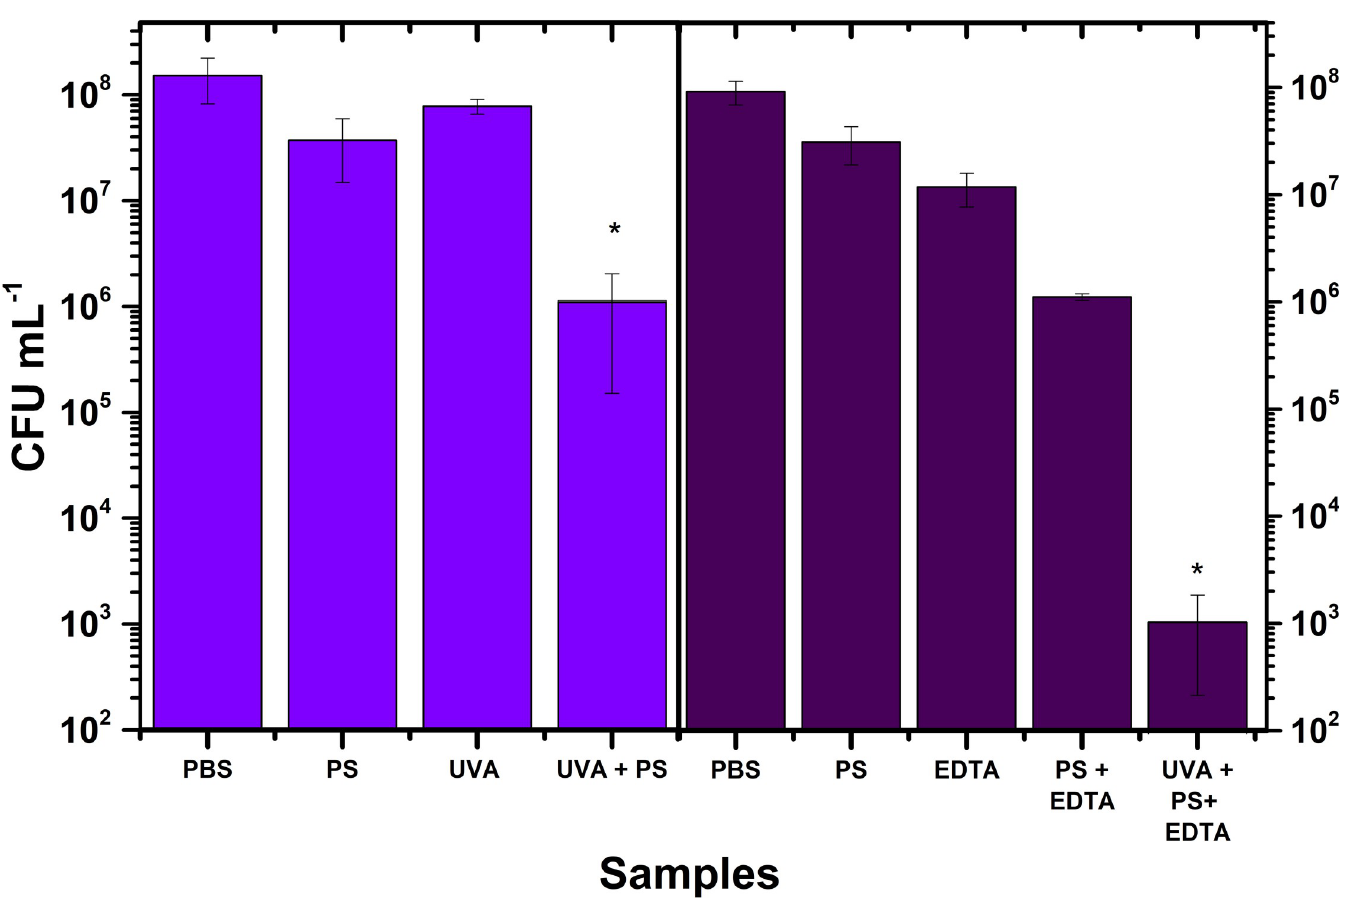
Fig 6. E . coli photoinactivation with pheomelanin nanoparticles excited with UVA radiation with and without EDTA (10 mM). The cultures at 166 μ g/mL of pheomelanin nanoparticles were irradiated during 3 h (270 J/cm 2 ). Controls are PBS, PS, UVA and EDTA. The strongest photoinactivation effect is depicted as UVA+PS +EDTA. Values are averages and standard deviations of three biological triplicate. � p < 0.05.